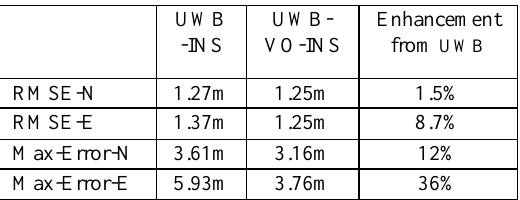
Table 3. The performance of the proposed approach (Camera and UWB integrated with INS) compared against the solution obtained from the UWB system alone (lower infrastructure) and the solution obtained from the camera alone integrated with INS (Configuration e)